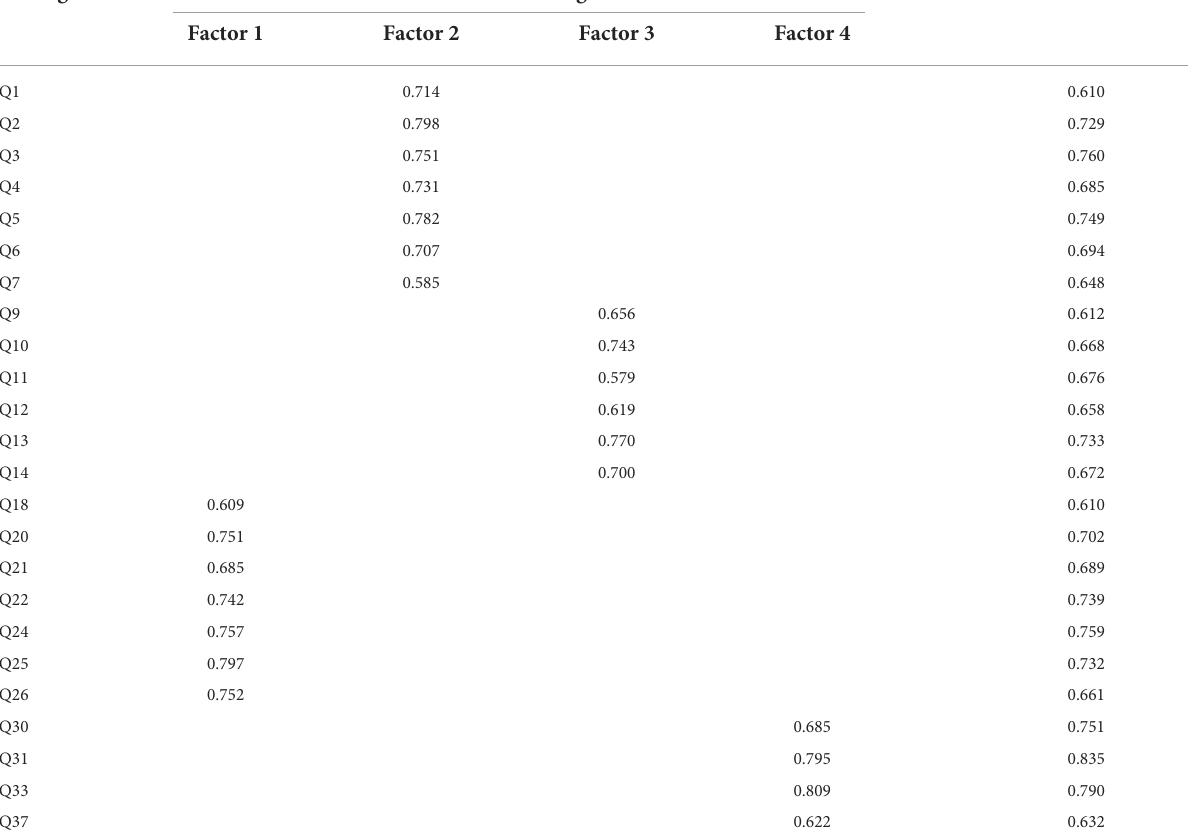
TABLE 4 Standardized factor loading